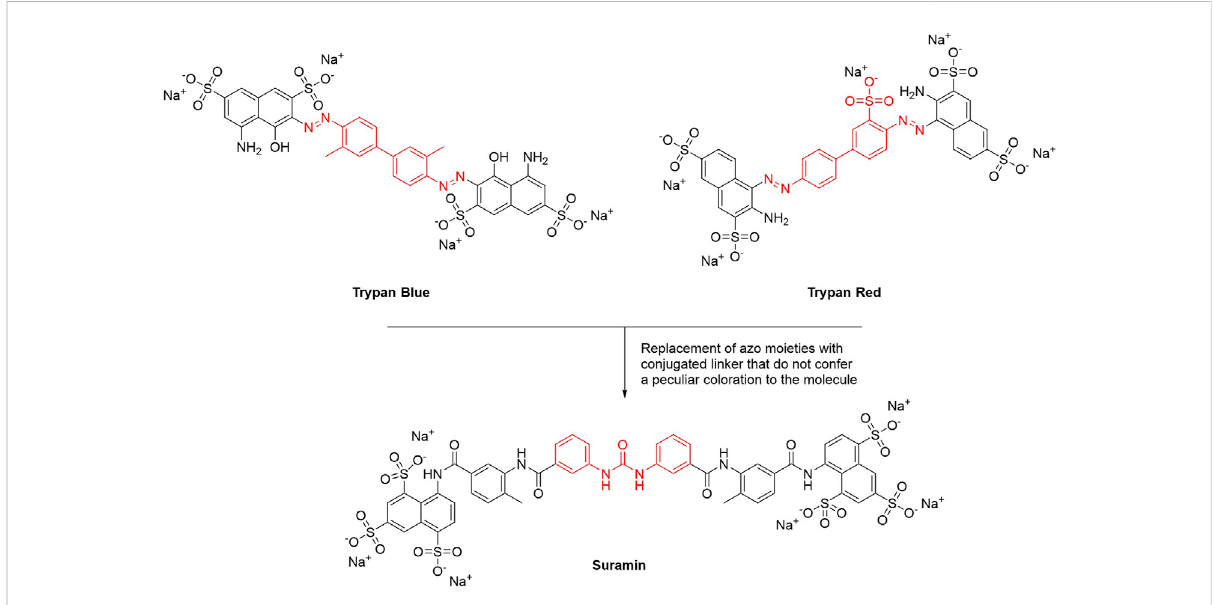
FIGURE 1 Chemical structures of suramin. The main structural modi fi cation that led to the discovery of suramin is highlighted in